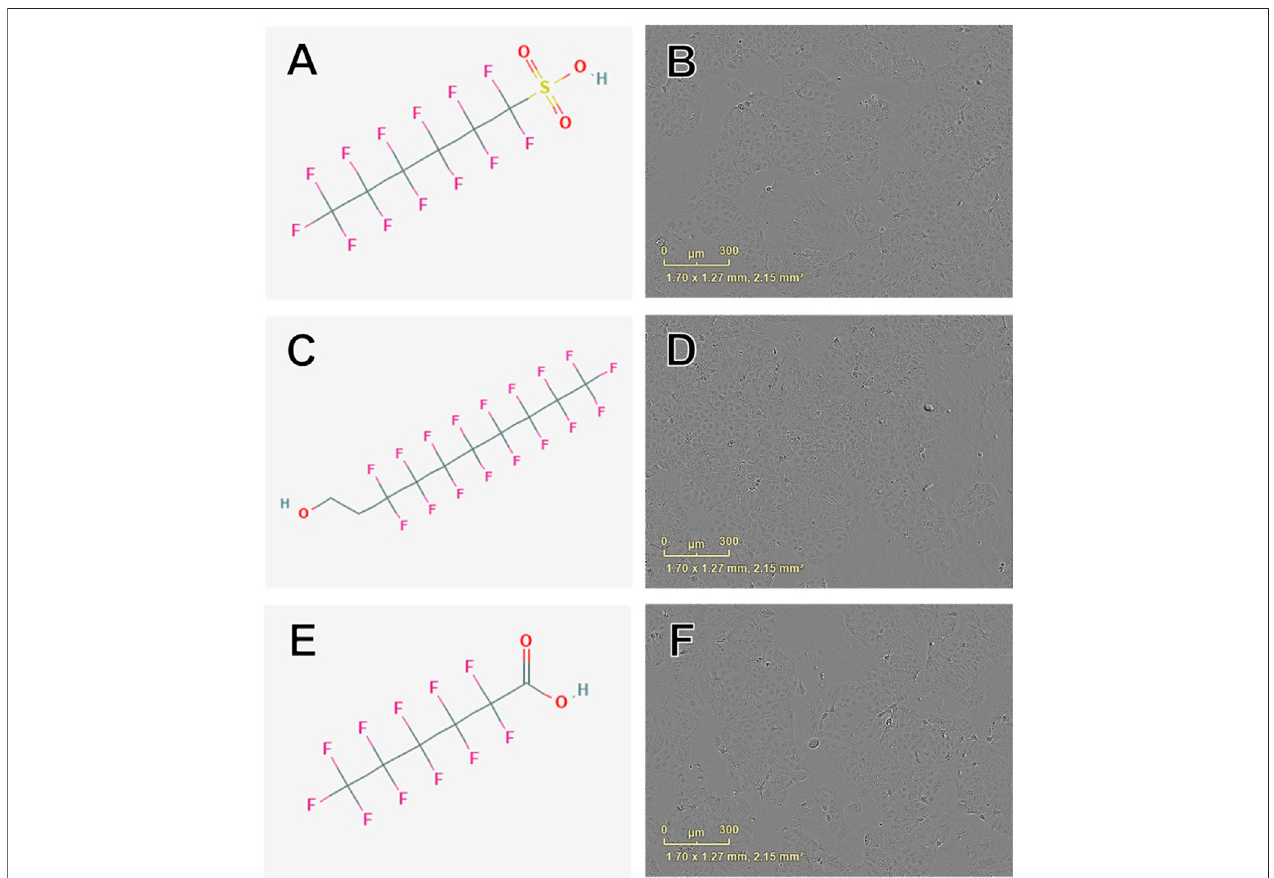
FIGURE 4| Examplesof chemical structures and corresponding phase contrast live cell images obtained from JEG-3 cells after 24 h exposure toPFAS with most pronounced effects on mitochondrial membrane potential. (A) Structure of per fl uorohexanesulfonic acid (355-46-4; EC50 ± SE: 86.2 ± 72.3 µM); (B) Live cell image of cellsexposedto150 µM355-46-4; (C) Structureof6:2 fl uorotelomeralcohol(678-39-7EC50±SE:95.4±17.1 µM); (D) Imageofcellsexposedto50 µM678-39-7; (E) Structure of per fl uorohexanoic acid (307-24-4; EC50 ± SE: 140.9 ± 11.10 µM); (F) Image of cells exposed to 150 µM 307-24-4. No overt cell death is apparent in (B) , (D) , or (F)